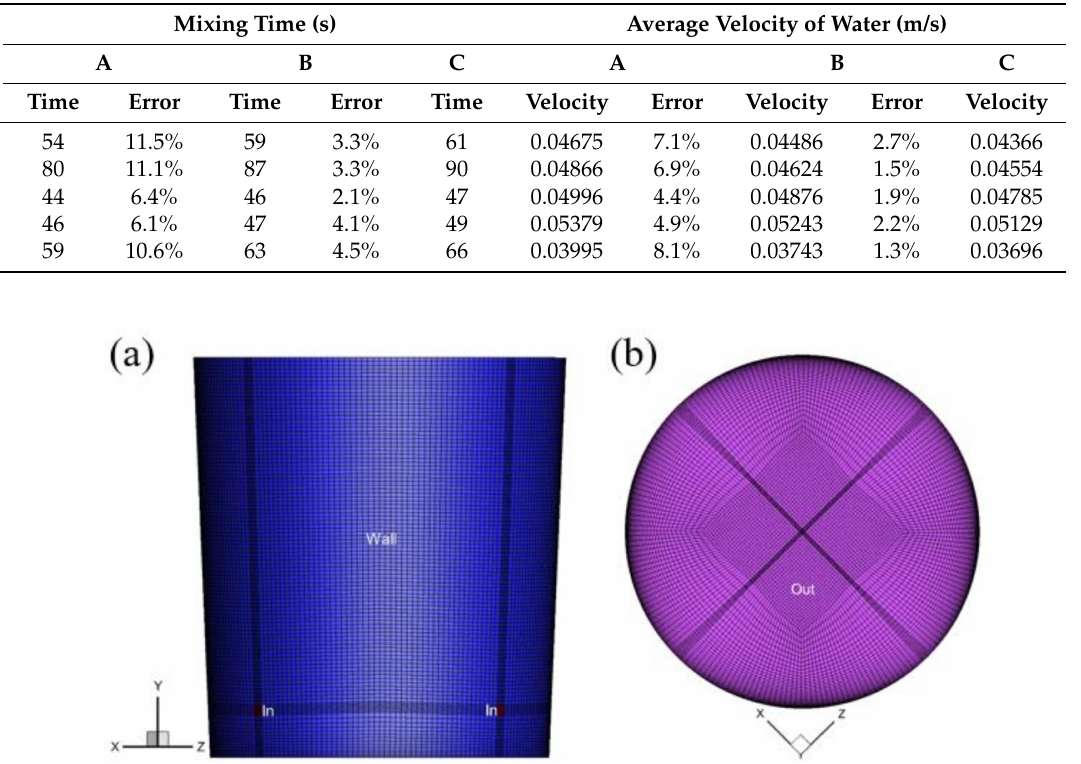
Table 4. Comparisons of water average velocity and mixing time.